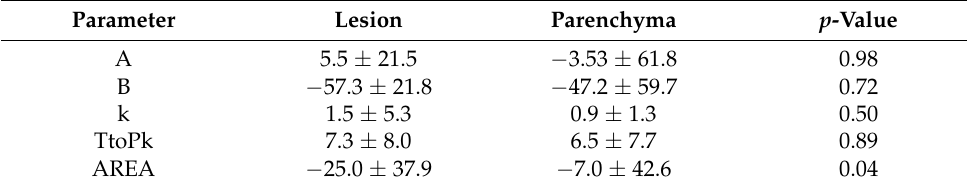
Table 3. Characteristics of the TIC analysis.